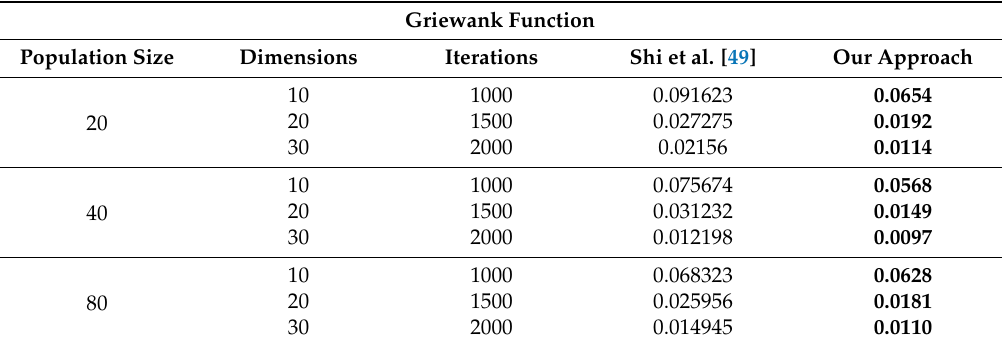
Table 18. Comparison against Shi et al.